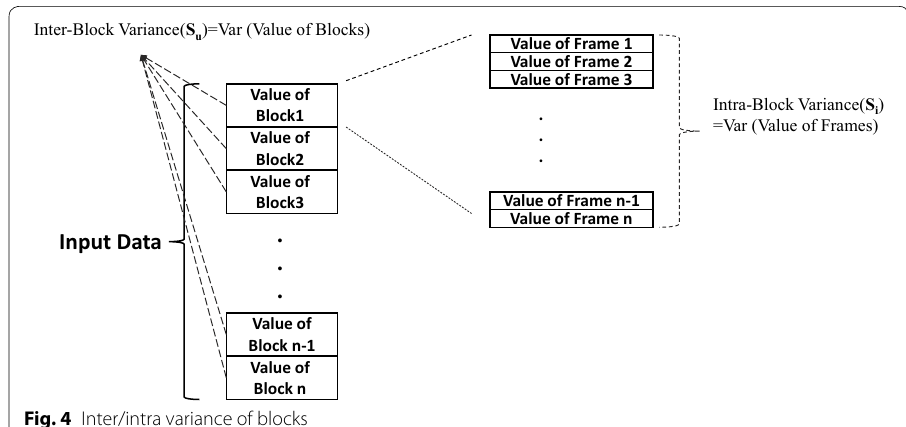
Fig. 4 Inter/intra variance of